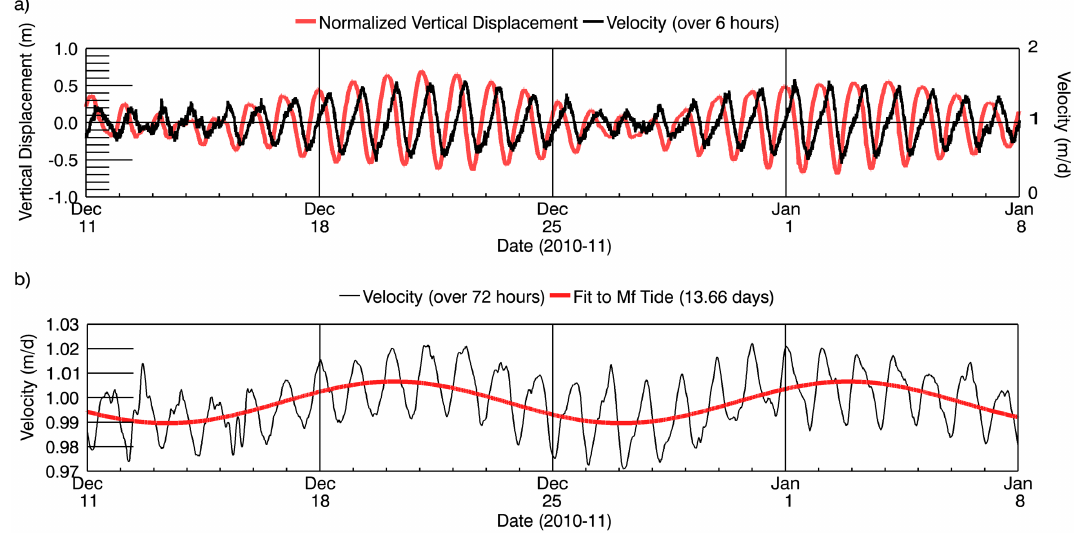
Fig. 2. (a) Recorded vertical displacement and 6h averaged surface velocity at GPS-3. Peaks in velocity match closely to peak rate of falling tide both in phase and amplitude. (b) 3-day running average velocity at the Beardmore grounding line from GPS data. Velocities show the outcome of 3-day repeat feature tracking. Short-term velocities throughout the paper are given in md − 1 instead of ma − 1 . Table 1. Modelled tidal height above mean sea level and inverse barometer effect derived from atmospheric pressure at “Elaine” weather station for individual TerraSAR-X acquisition dates. TSX ID Date Tide (m) Atmospheric Inverse barometer (CATS 2008opt) pressure (hPa) effect